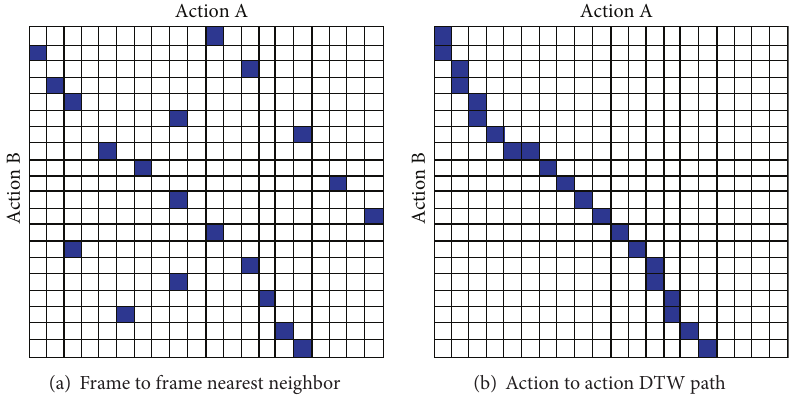
Figure 4: Compare k-NN with DTW.